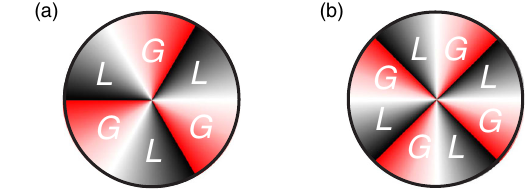
FIG. 5. Examples of the MT 2 group with (a) v ¼ 3 and v (b) v ¼ 4 . Similarly to the schematics in Figs. 1 and 4, black and red regions represent loss ( L ) and gain ( G ), and the transparency of the colors shows their